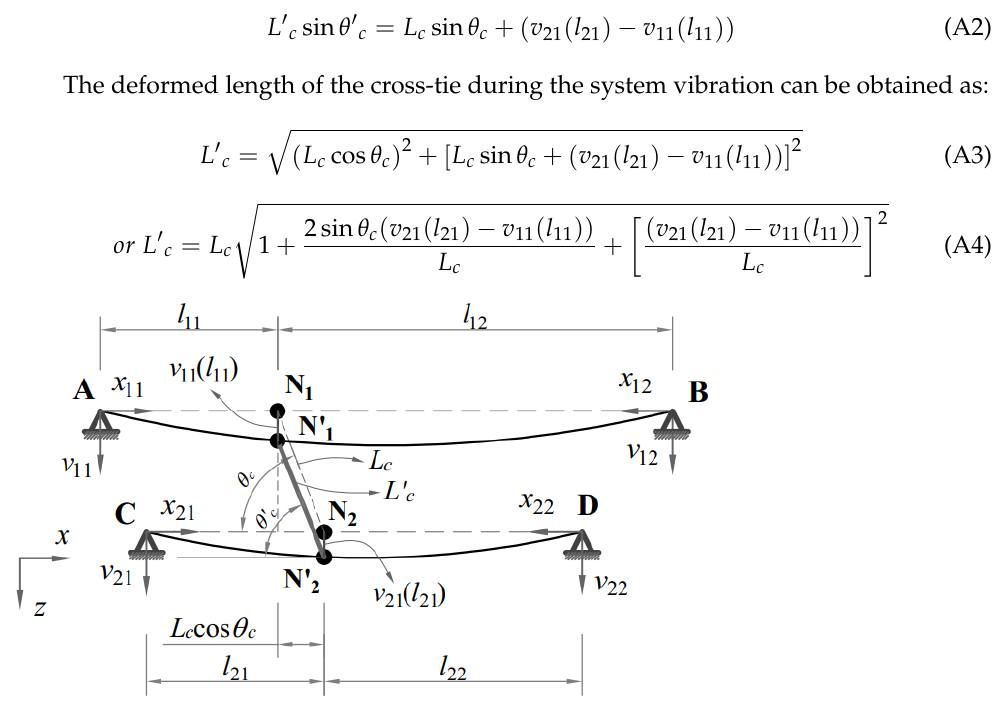
Figure A1. Deformed shape of the cables and cross-tie.